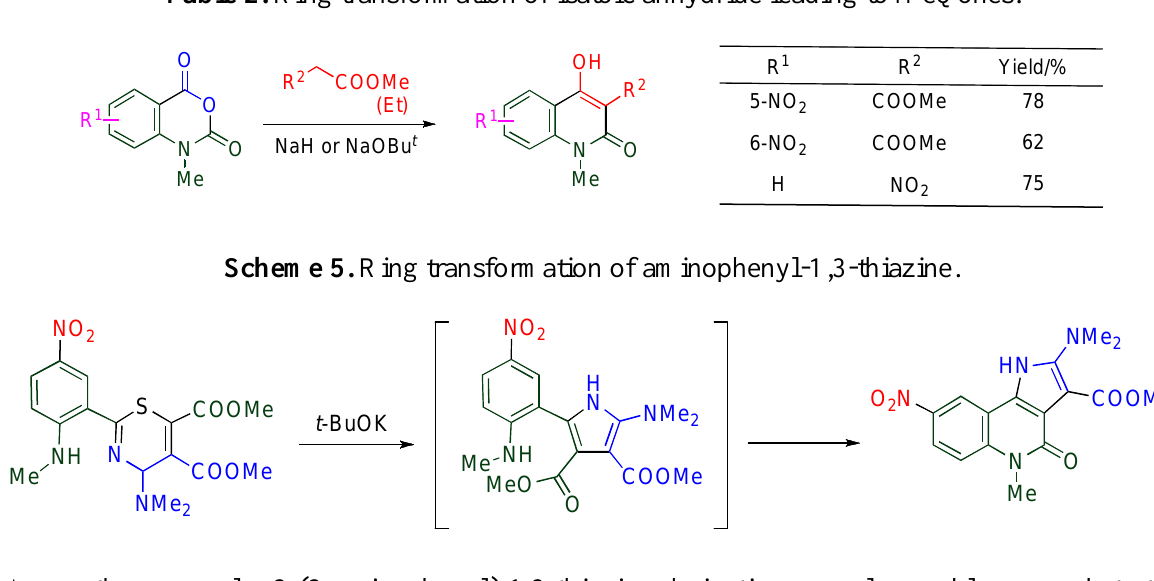
Table 2. Ring transformation of isatoic anhydride leading to MeQones.